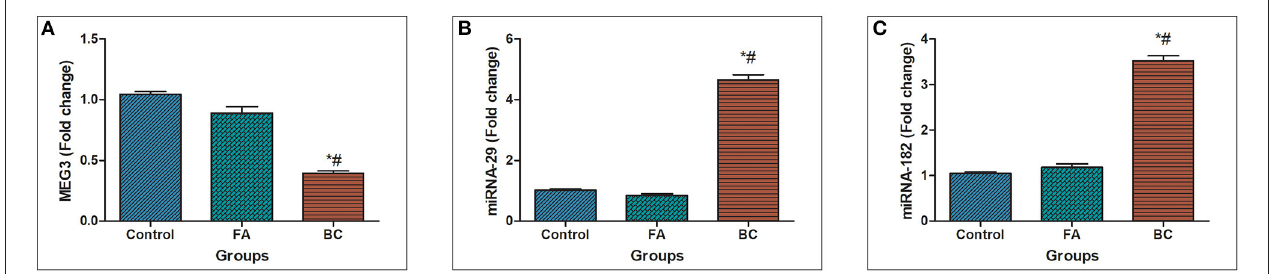
OR, odds ratio; 95% CI, 95% confidence interval. Results are expressed as number and in parentheses percent. P < 0.05 is considered statistically significant after adjusting for age, sex, and BMI. Chi squared (X 2 ) test was performed to compare categorical data.